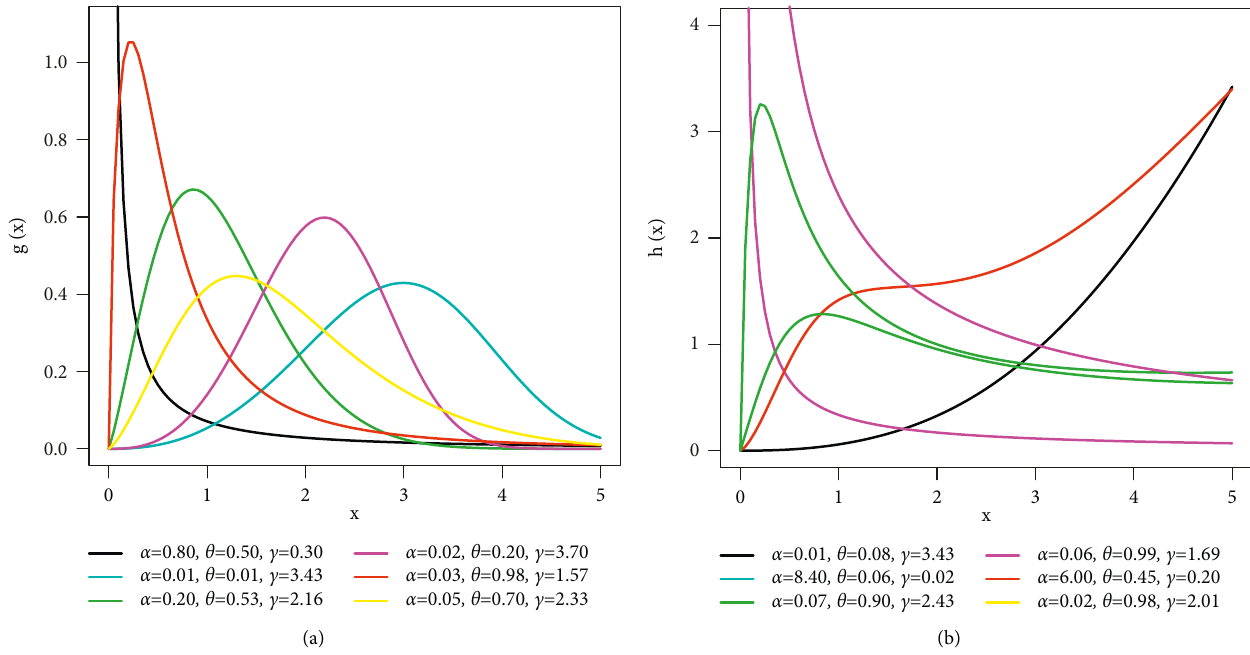
Figure 1: (a) PDF and (b) HRF plots of the SWGI